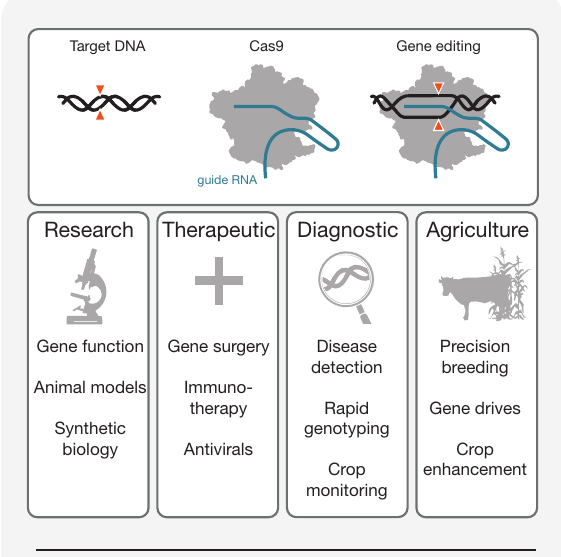
Figure 2. Naturally occurring microbial CRISPR systems have been engineered for gene editing (Top). Cas9 uses a guide RNA comple- mentary to a target genomic locus to selective fi nd and cleave that precise location in the genome (Bottom). CRISPR-based technologies are being deployed in a number of diverse fi elds, including basic research, therapeutics, diagnostics, and